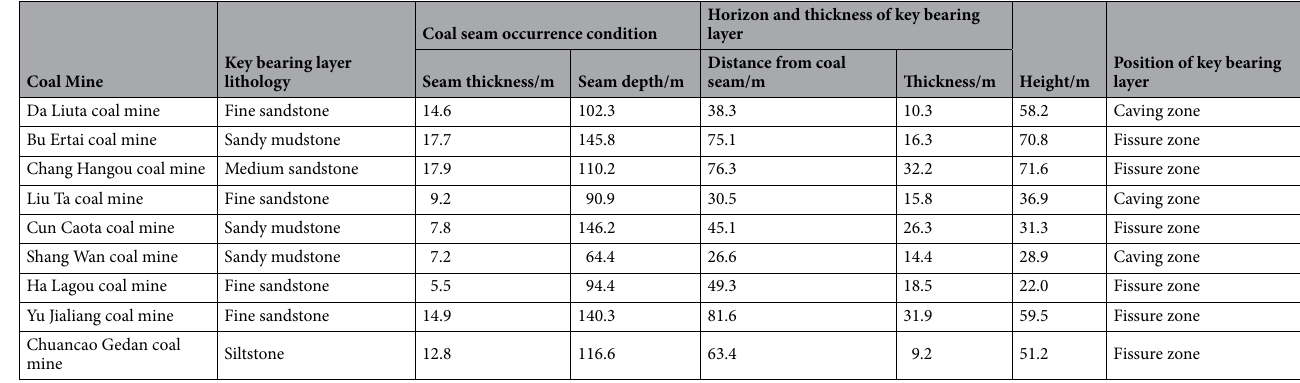
Table 1. Statistics of the overburden rock occurrence characteristics of shallow thick seam mining in Western China (the rock hulking coefficient in the caving process is 1.25).